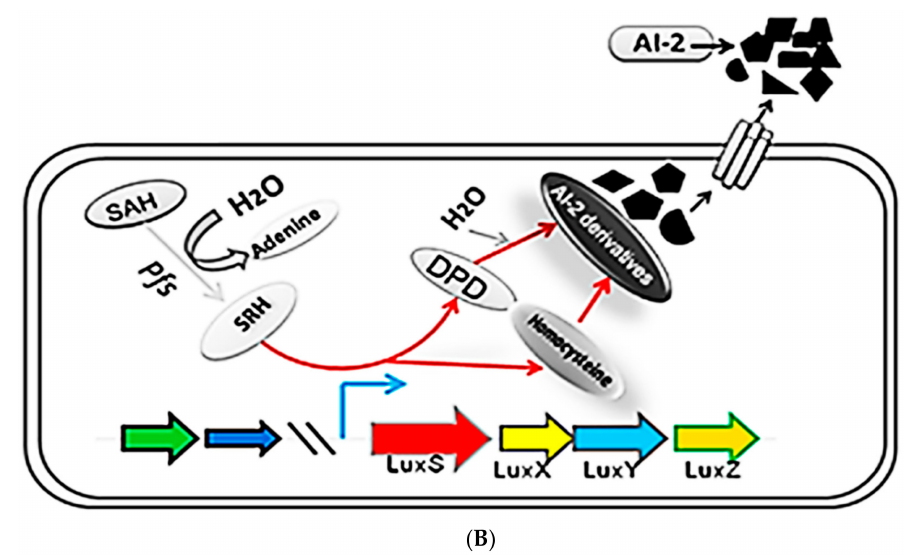
Figure 1. Chemical ( A ) and graphical ( B ) pathways of AI-2 biosynthesis, showing the synthesis of AI-2 via the QS LuxS system in A. hydrophila . luxS homologs are labeled as LuxX, LuxY, and LuxZ. Pfs converts S-adenosylhomocysteine (SAH) into S-ribosyl homocysteine (SRH) and adenine. LuxS converts SRH into AI-derivatives/precursors such as 4,5-dihydroxy-2,3-pentanedione (DPD) and homocysteine, and DPD spontaneously undergoes cyclization to produce AI-2. AI-2 molecules are emitted from bacterial cells via membrane protein channels, wherein they become active in quorum sensing.